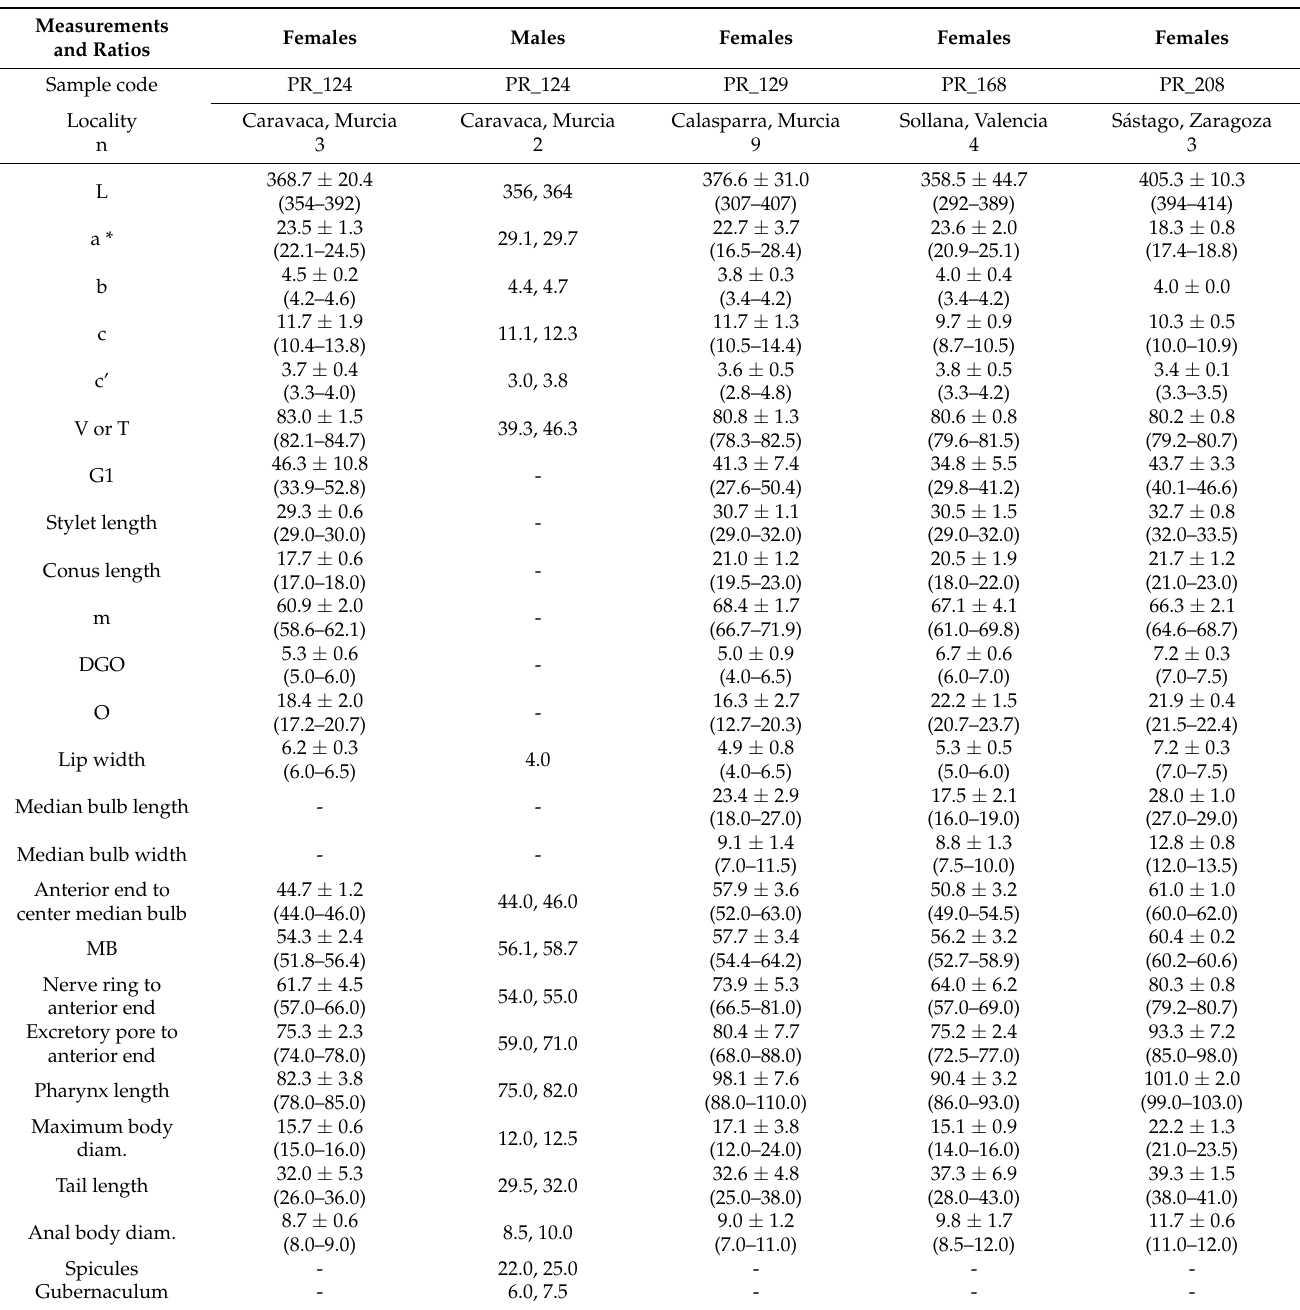
Table 8. Morphometrics of Paratylenchus tenuicaudatus Wu, 1961 from several localities in Spain. All measurements are in µ m and in the form: mean ± s.d.